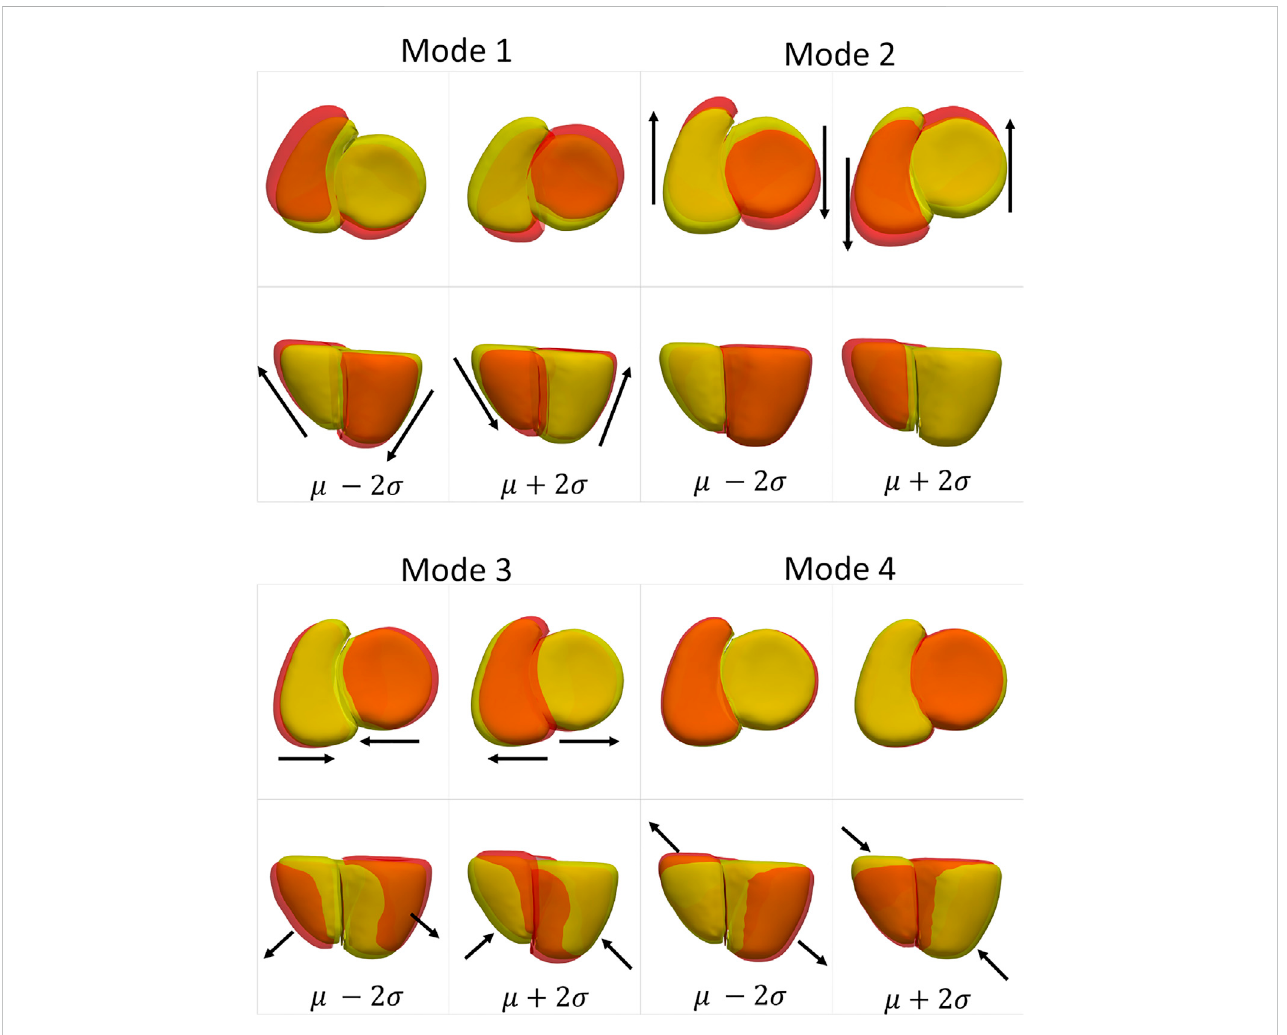
FIGURE 7 Alignment variations identi fi ed using multi-level component analysis for the cardiac dataset. The surface meshes in yellow represent the mean reconstructed shape, and the surface meshes in red represent the shapes at μ +2 σ and μ − 2 σ . The black arrows indicate the direction of the variation of the